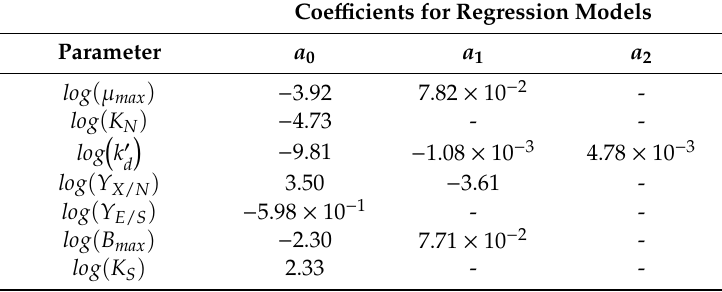
Table 4. Coe ffi cients for estimating fermentation model parameters as a function of temperature, where: Parameter = a 0 + a 1 T + a 2 T 2